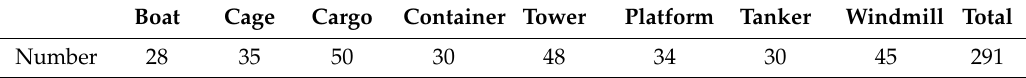
Table 13. Composition of the 1.7 m ground resolution target classification dataset.